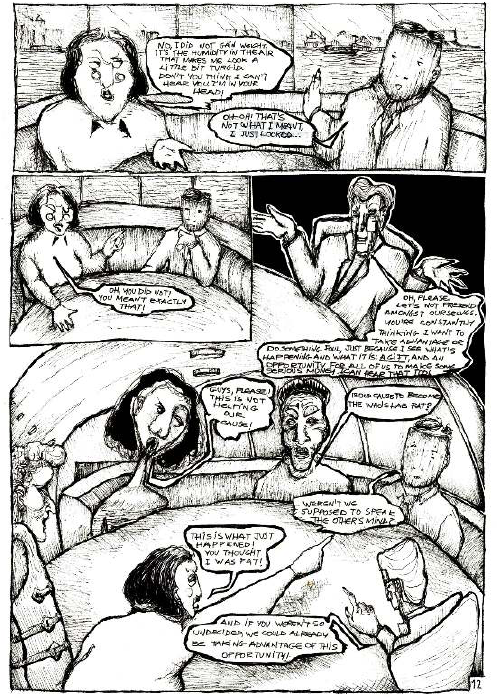
Figure 13: Plate 12, Diamond Princess II